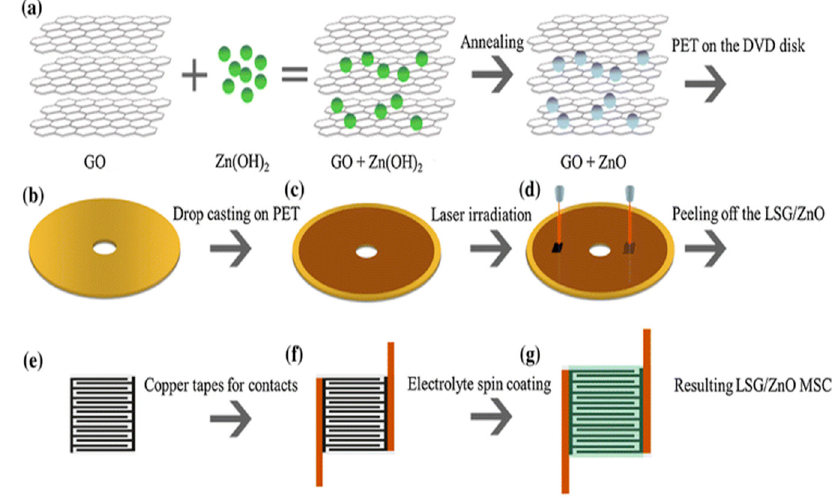
Figure 3. ( a ) Schematic representation of the fabrication of ZnO/GO nanocomposites. ( b – g ) Steps depicting the formatting of micro-supercapacitors. Reproduced from Amiri, M.H., Namdar,